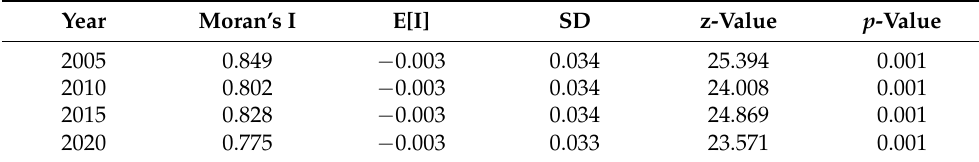
Table 2. China Regional PM2.5 Concentration Global Moran’s